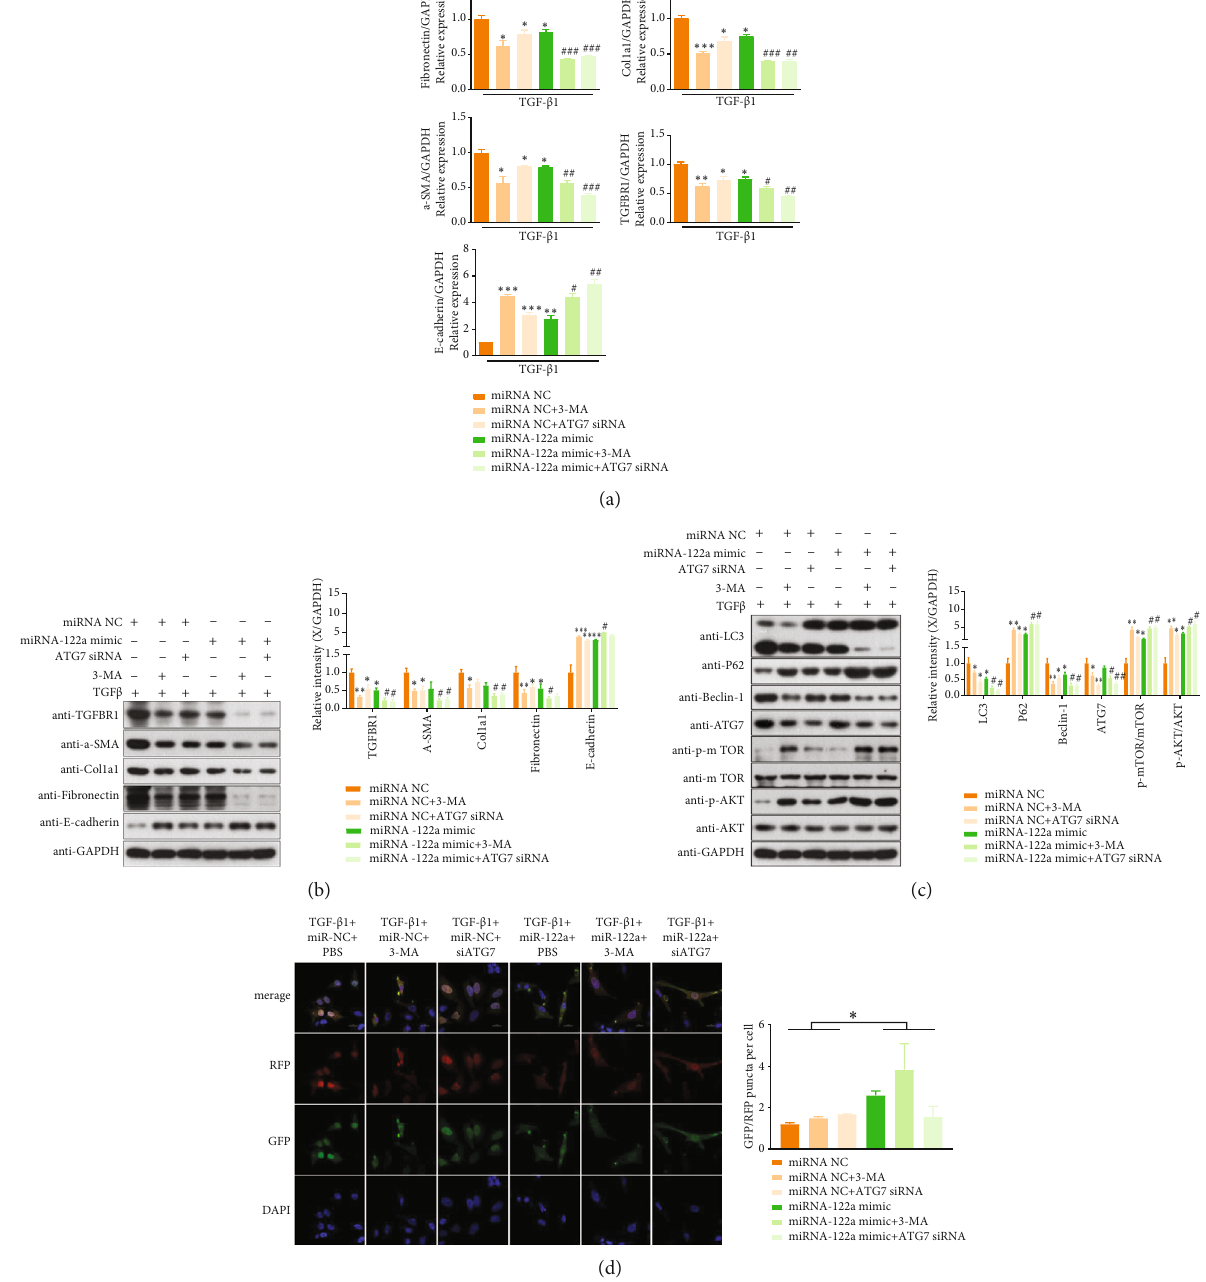
Figure 4: miRNA-122a relieves renal fi brosis caused by TGF β in HK-2 cells through autophagy signaling and autophagic fl ux. (a) TGFBR1, α -SMA, Col1a1, fi bronectin, and E-cadherin mRNA levels were measured by qPCR in HK-2 cells. (b) Western blotting analysis of TGFBR1, α -SMA, Col1a1, fi bronectin, and E-cadherin protein expression in HK-2 cells. Quantitative analysis of TGFBR1, α -SMA, Col1a1, fi bronectin, and E-cadherin protein expression is shown on the right ( n = 3 independent experiments). (c) LC3II/I, p62, Beclin 1, ATG7, mTOR, p-mTOR, AKT, and p-AKT protein expression was evaluated by western blotting in HK-2 cells, and their quantitative analysis is shown on the right ( n = 3 independent experiments). (d) The e ff ect of miRNA-122a mimic on autophagy fl ux after treatment with an autophagy inhibitor in HK-2 cells as detected by confocal scanning laser microscopy. Results are expressed as the mean ± SEM . Compared with the miRNA-NC+TGF β group, ∗∗∗ P < 0 : 001 , ∗∗ P < 0 : 01 , and ∗ P < 0 : 05 . Compared with miRNA-122a mimic+TGF β , ### P < 0 : 001 , ## P < 0 : 01 , and # P < 0 : 05